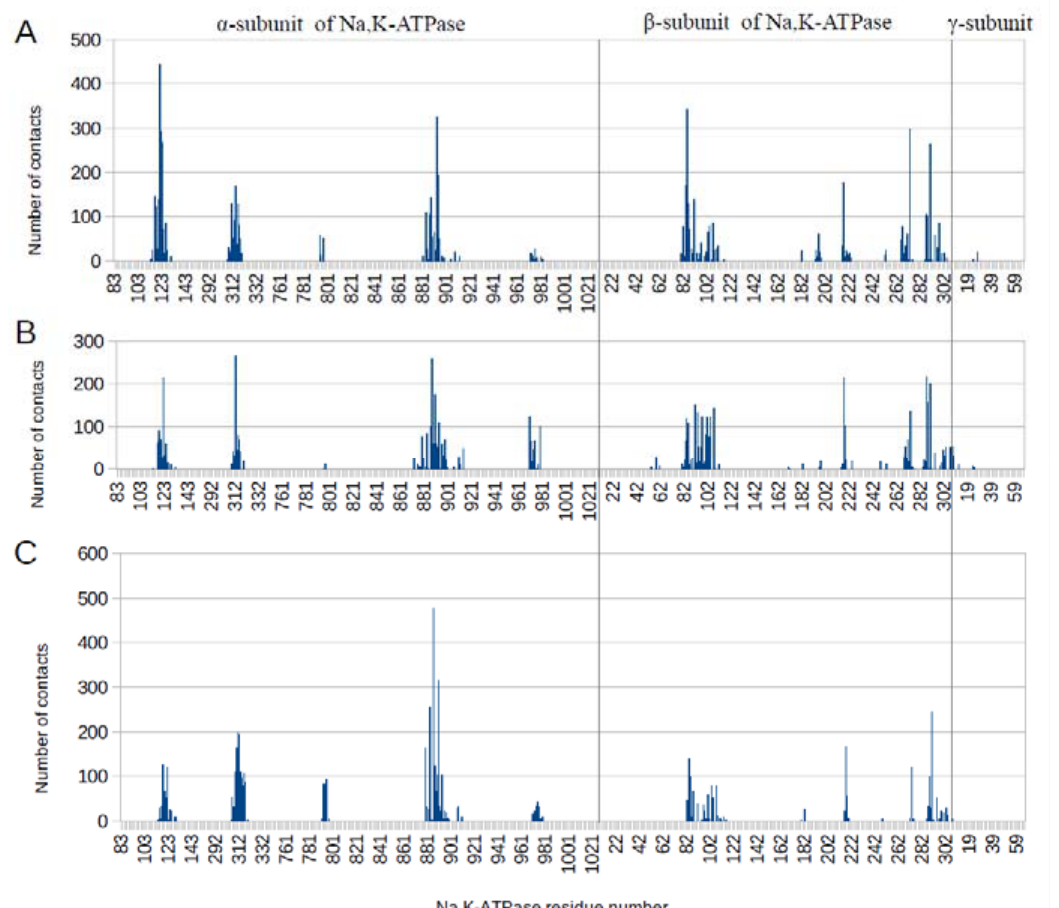
Figure 3. The number of intermolecular contacts with three A β isoforms after 30–50 ns of MD in E1P ( A ), E2P ( B ), and OBN ( C ) conformations of α 1 isoform of human Na, K-ATPase. The data